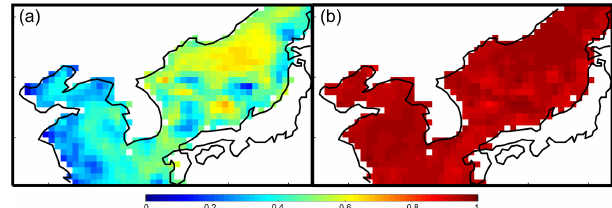
Figure 11. (a) Correlation coefficient map between Hamlington et al. (2011) and AVISO over 1993–2008; (b) correlation coefficient map between this study and AVISO over 1993–2008.